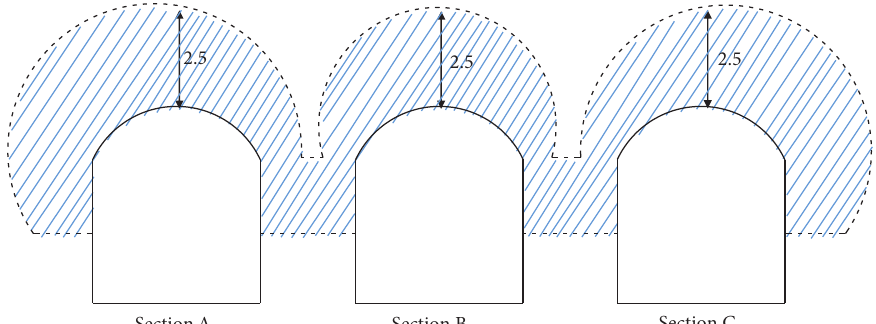
Figure 12: Reinforced section view.